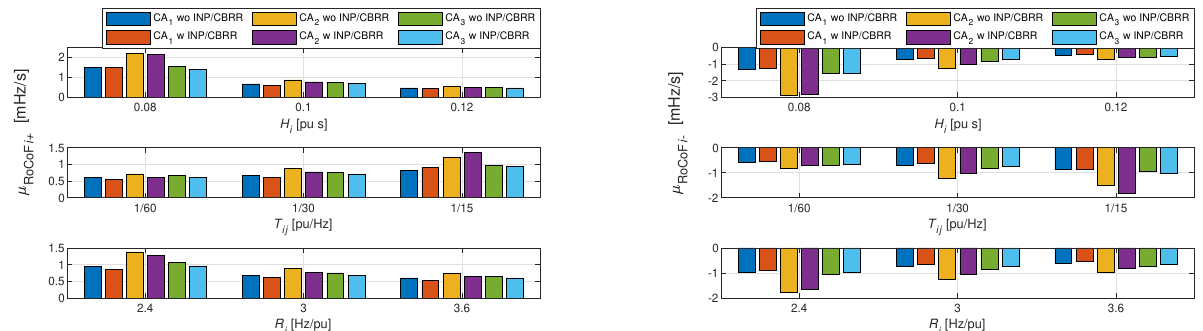
( left ) and average values of µ RoCoF i +